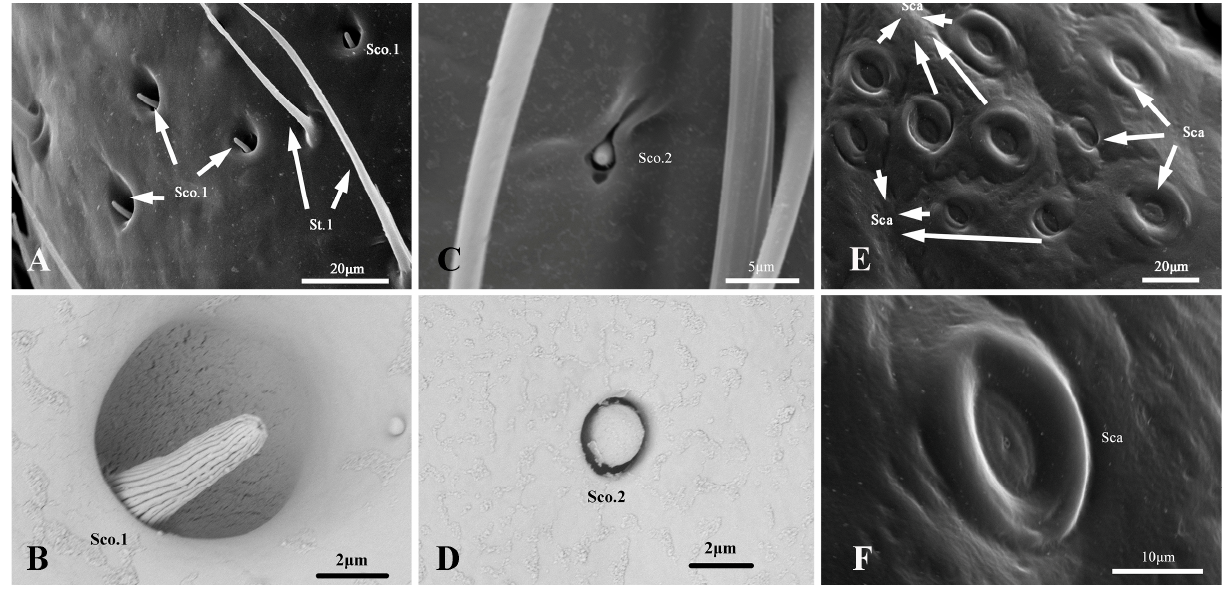
Figure 8. ( A – D ). Sensilla Coeloconica of N. meleagris antennae; ( E – F ). Sensilla Campaniformia of N. meleagris antennae.